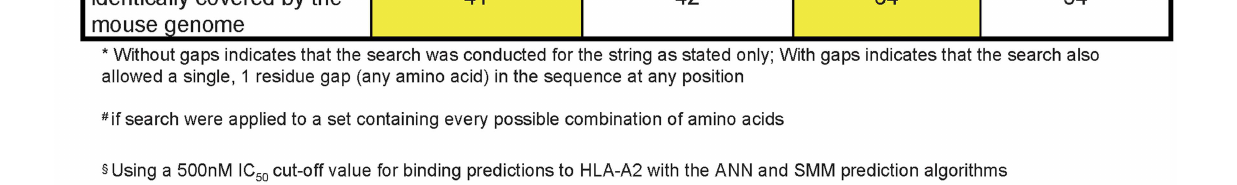
For (B,C) , peptides were subjected to ANN and SMM prediction algorithms along with SYFPEITHI and BIMAS, and prediction to bind above the arbitrary thresholds described in the text in any of the algorithms was taken to indicate a potential binder. (D) A comparison of MAGE-A3 andWT1 proteome scan results.The total number of predicted binders identified in the human proteome and the percent of the binders identically found in the mouse proteome for both epitopes (searched without gaps) are highlighted in